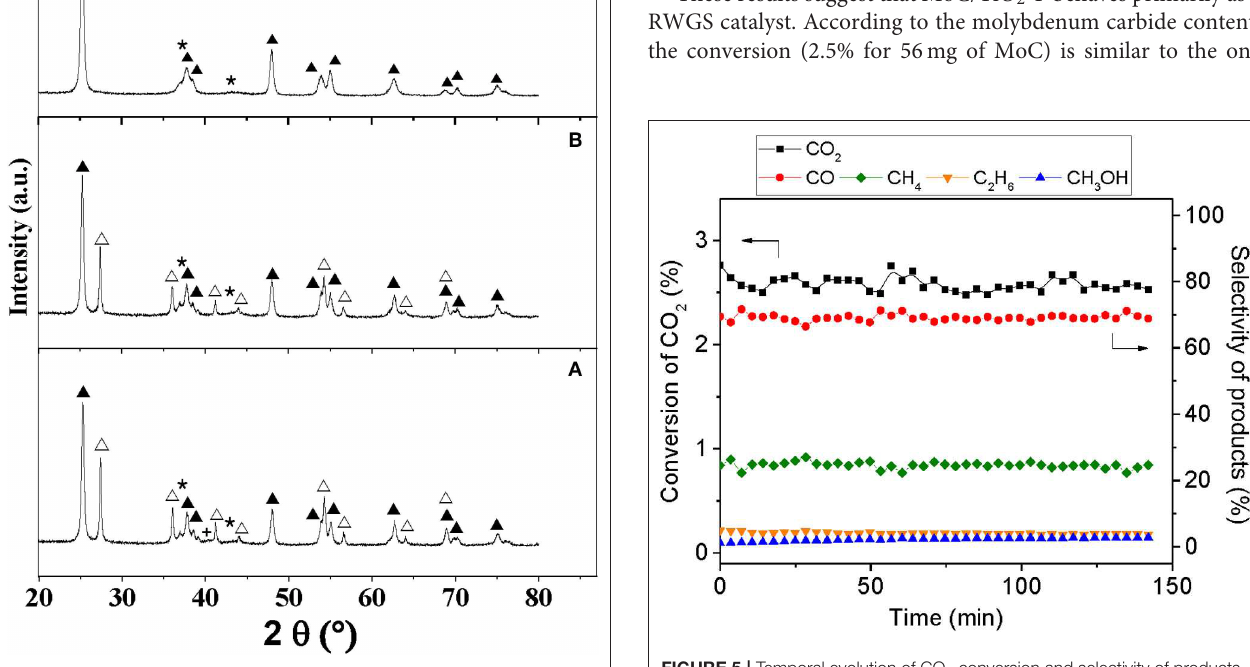
FIGURE 3 | XRD patterns of the catalysts: (A) MoN A /TiO 2 - P, (B) MoN B /TiO 2 - P, and (C) MoN B /TiO 2 -D. Assignment of peaks: ( N ) anatase, ( △ ) rutile, ( ⋆ ) MoN, and ( + ) Mo.